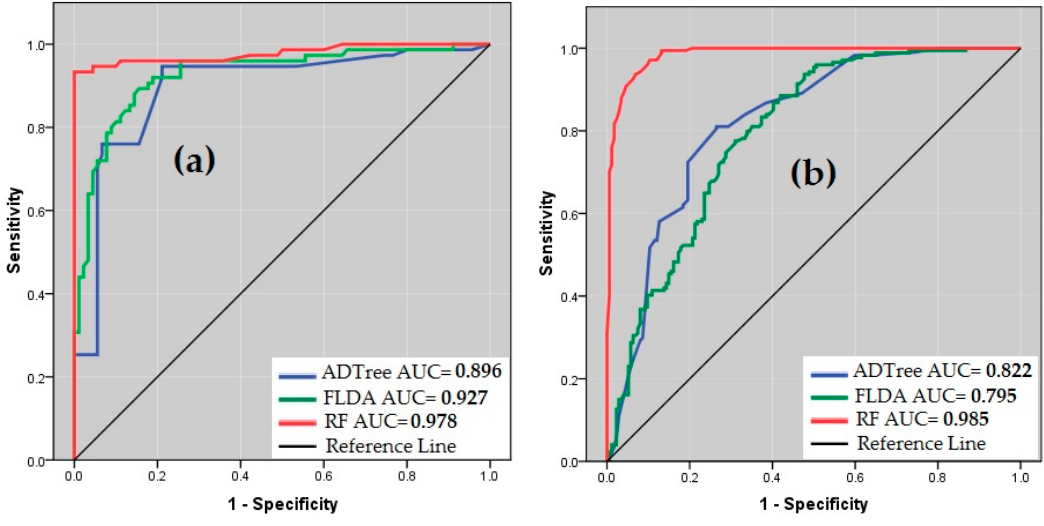
Figure 8. Validation of results: ( a ) Success rate curve (SRC), ( b ) Prediction rate curve (PRC). Table 4. Percentage of each susceptibility class along with SCAI values.